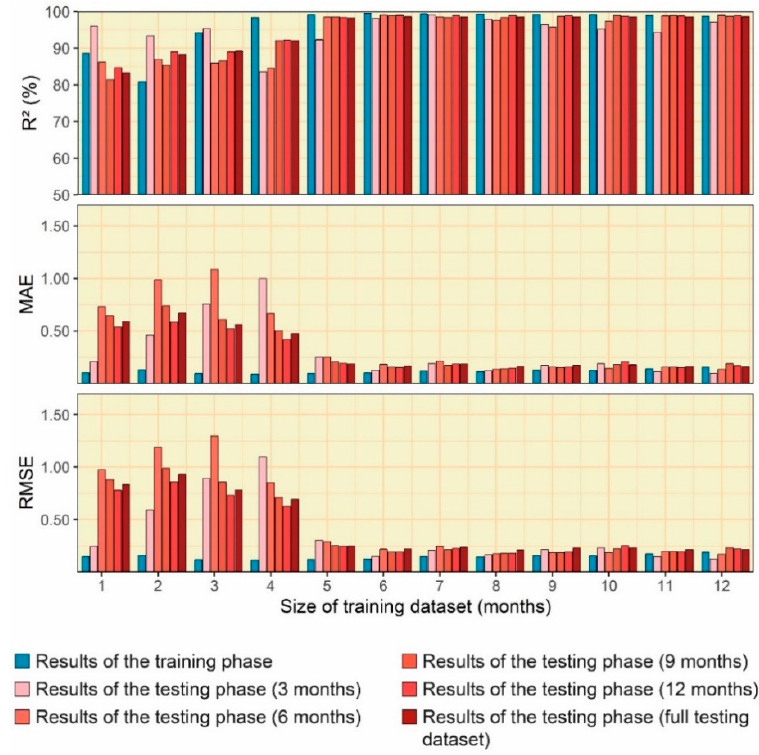
Figure 12. Influence of the size of the training sample on the MLP model (approach 2).